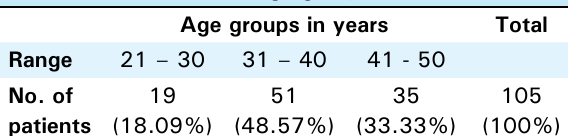
table 2. Distribution of age group.